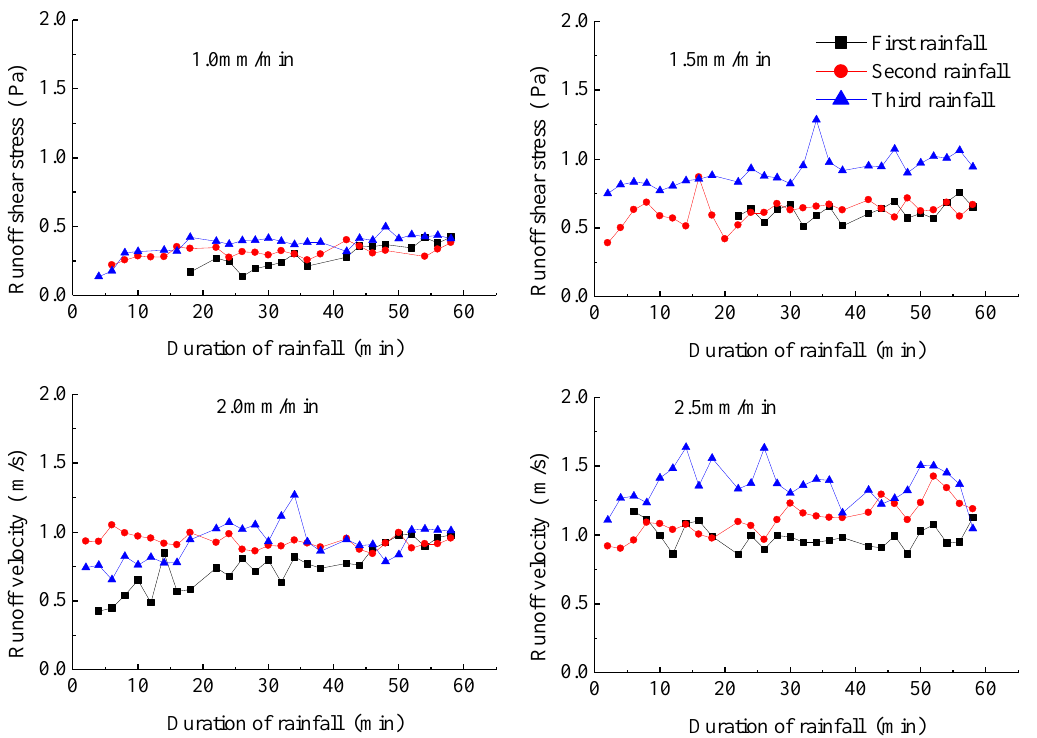
Figure 15. Variation curve of runoff shear stress with time of the sand-covered slope at different rainfall densities.